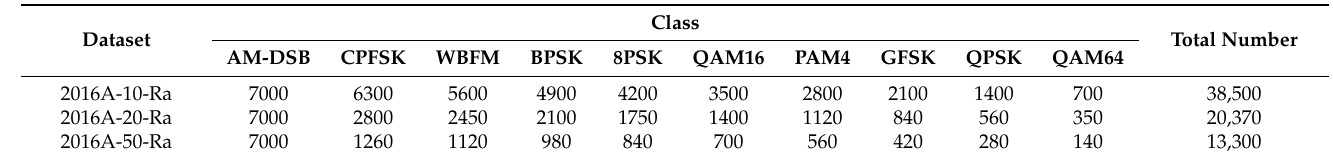
Table A3. Number of samples per class in the datasets created by random shuffling of the original class list.